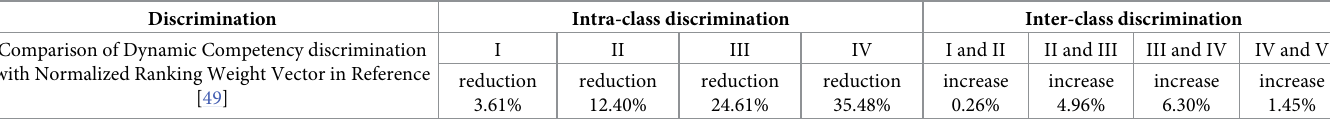
Table 17. Comparison of the clustering discrimination of dynamic competency of 10 bid evaluation